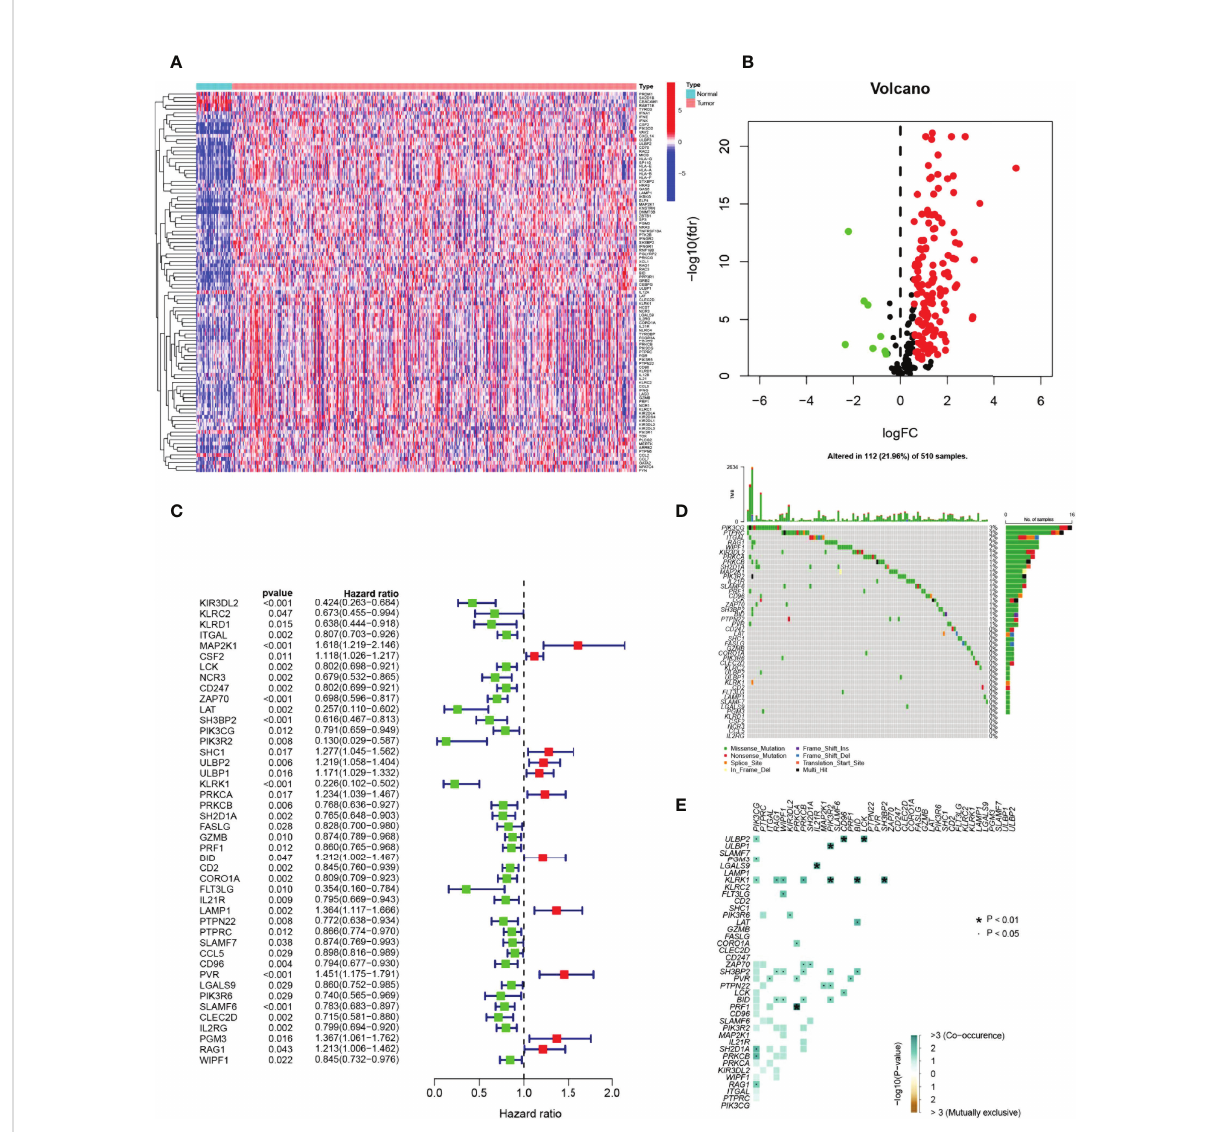
FIGURE 2 Identi fi cation of candidate NRGs. (A, B) Heat map and volcano plot of differentially expressed NRGs. (C) Prognosis of 44 NRGs in the whole HNSCC cohort analyzed by univariate Cox regression model. (D) Oncoplot of 44 mutant NRGs in the HNSCC cohort. (E) Co-mutation analysis of